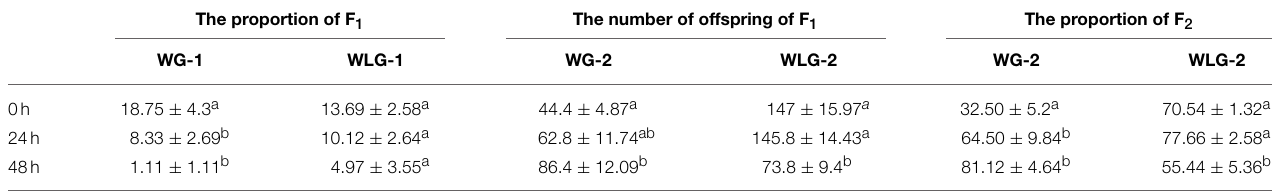
TABLE 1 | The number of offspring and proportion of the winged individuals derived from the winged and wingless adults. The proportion of F 1 The number of offspring of F 1 The proportion of F